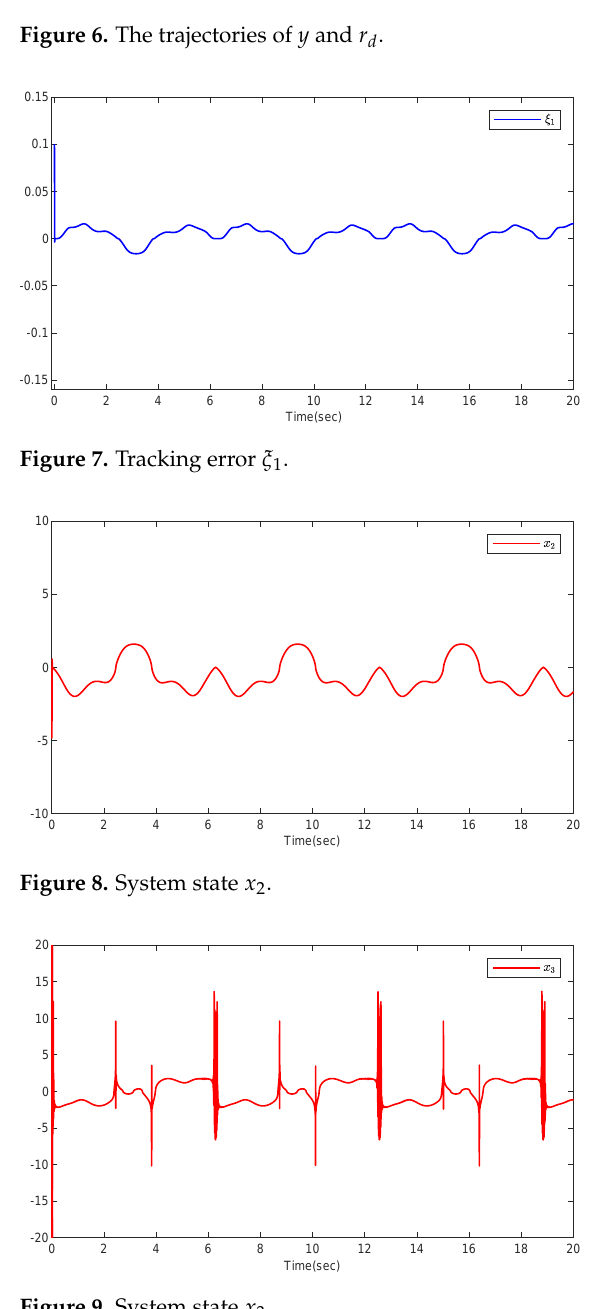
Figure 9. System state x 3